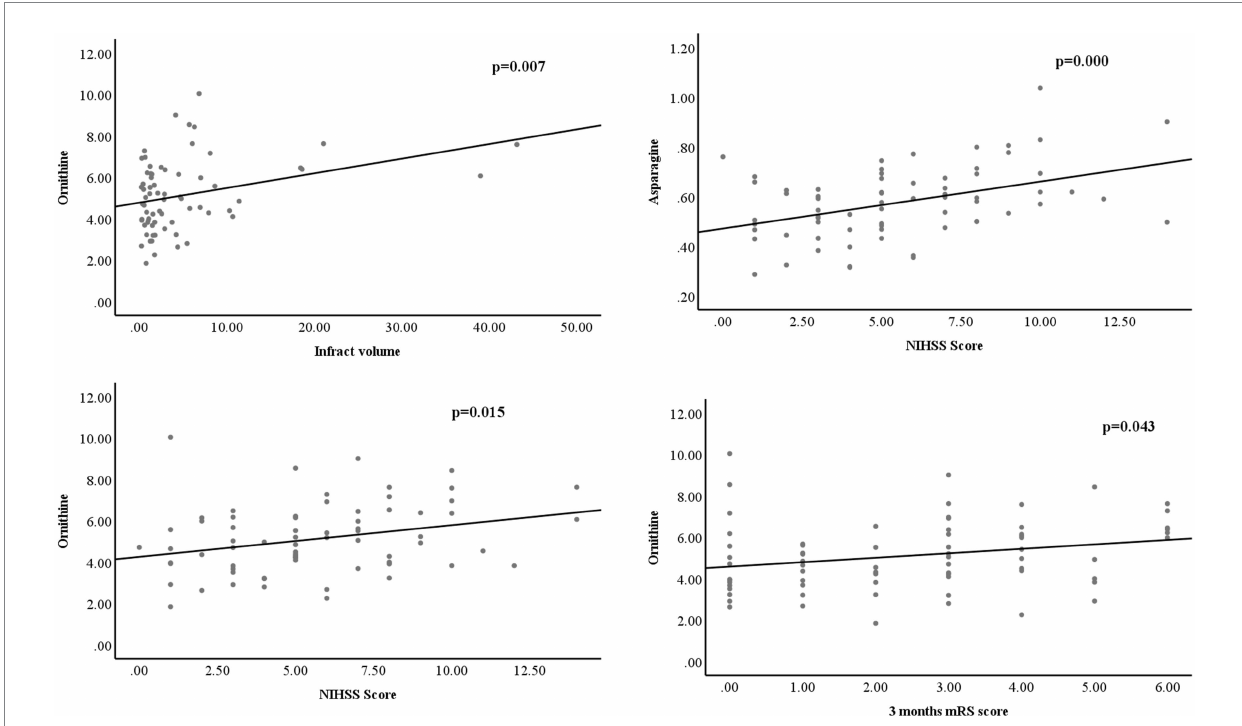
FIGURE 3 levels of ornithine were positively associated with infract volume, 3 months mRS score, and NIHSS score in MB, asparagine was positively associated with NIHSS score.